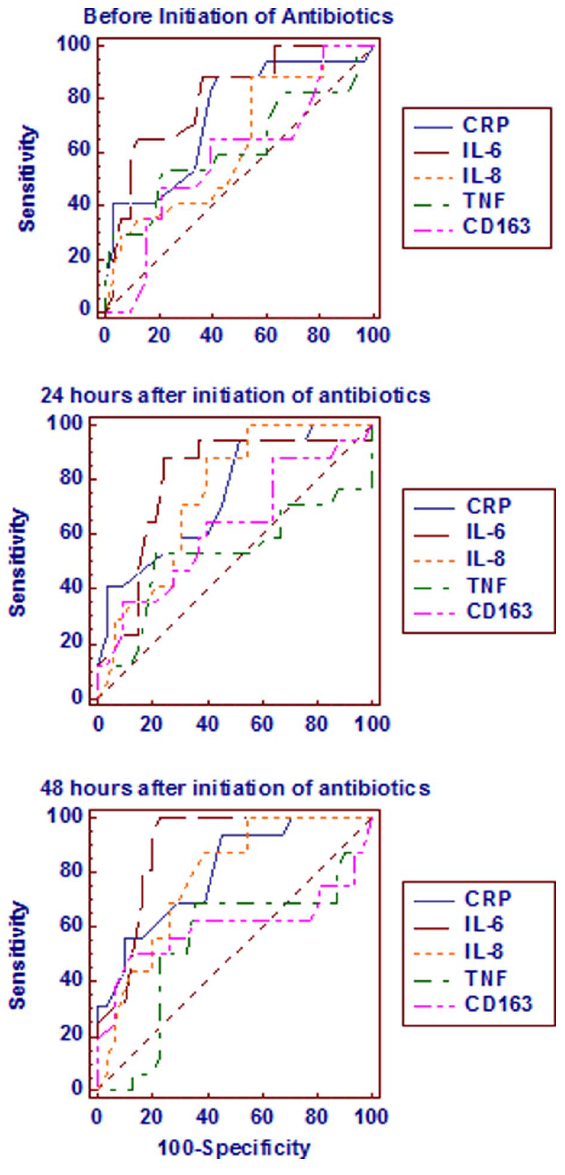
Figure 2. Comparison of the receiver operative curves of all the study parameters between the survivors and non-survivors of the infected group at different time intervals.